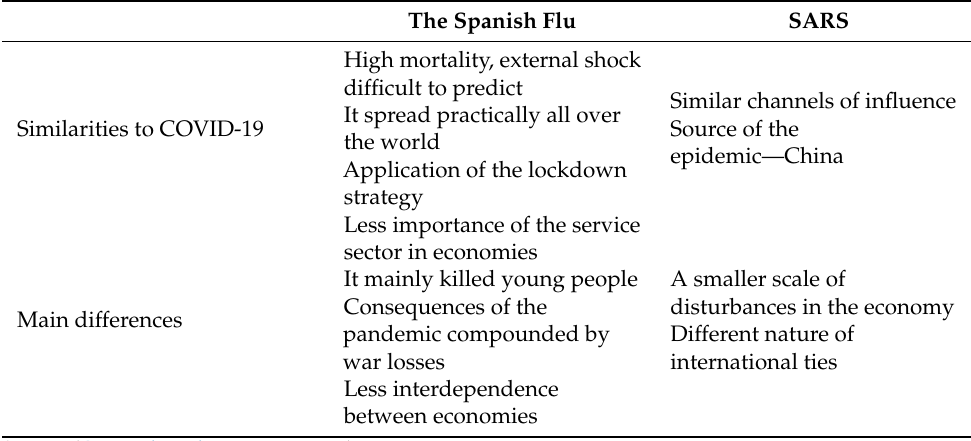
Main differences